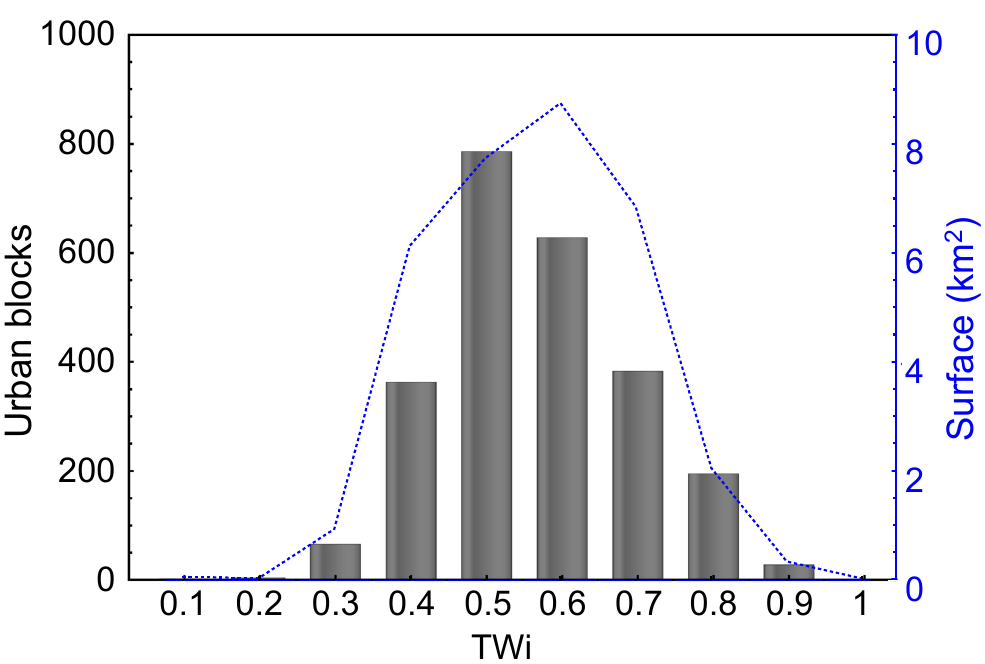
Figure 5. Spatial socioeconomic distribution per surfaces and urban blocks in Arica by rank. The dispersion of data will be sectorized based on those census districts located in the study area and with information on socioeconomic ranges, namely Puerto, Regi- miento, Chinchorro, San José, Población Chile, Azapa, José Manuel Balmaceda, Carlos